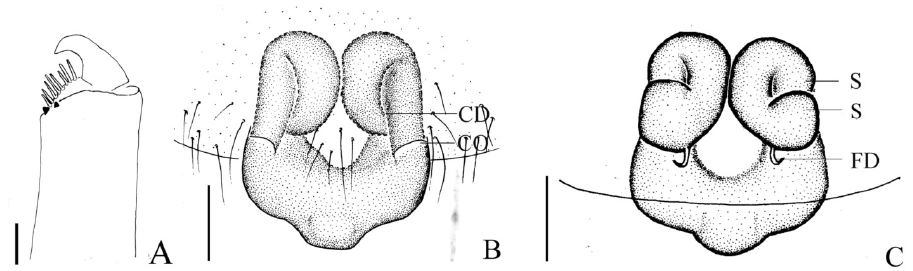
Figure 10. Mimetus wangi sp. n., one of the female paratypes. A left chelicerae, ventral view B epigynum, ventral view C vulva, dorsal view. Scale bars: A–C , 0.1.